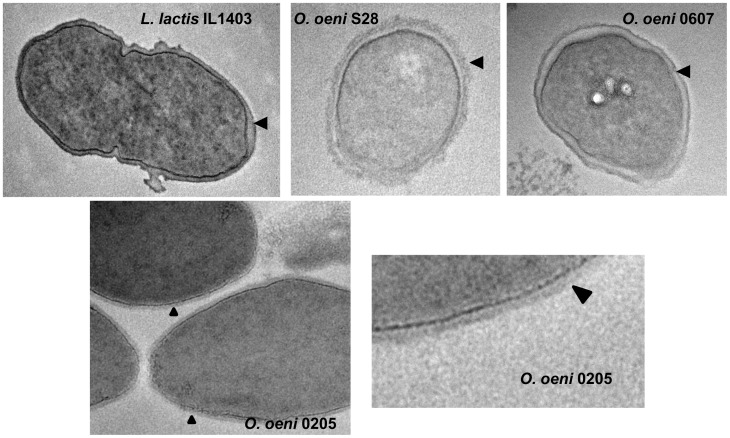
Observation of O. oeni capsules by transmission electron microscopy.The black arrow indicates the place where the capsule may appear as a dark halo/layer when present. The strain L. lactis IL1403, which displays a thin polysaccharide pellicle as demonstrated by Chapot Chartier et al. [70], serves as a reference. Strains O. oeni S28 and 0607 are clearly encapsulated, while strain 0205 has no dense area beyond the peptidoglycan layer (light gray layer).